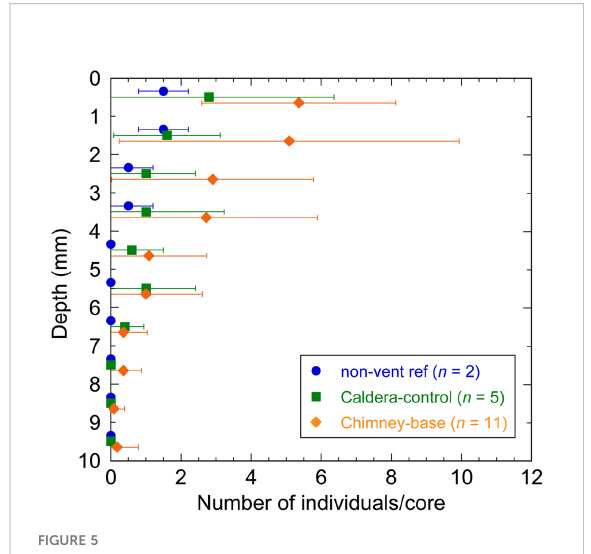
FIGURE 5 Vertical pro fi les showing the mean abundance of total eukaryotes (minus fl agellates) at mm-scale downcore. Means and error bars (1SD) were calculated for each